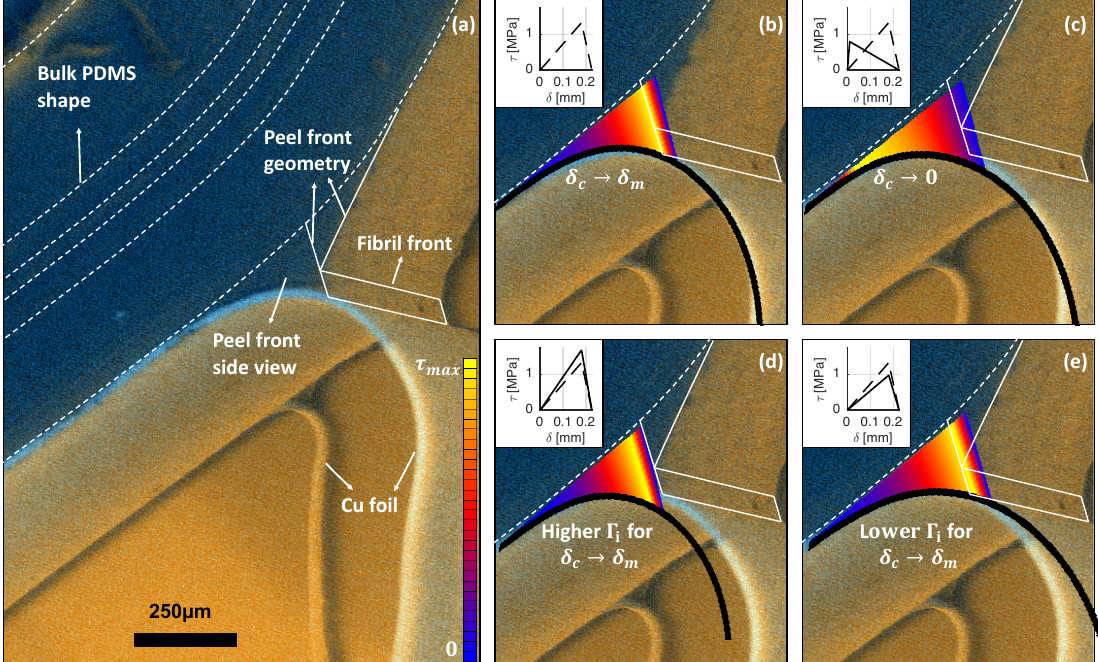
Figure 7. Side view of the ESEM images of the alternative 180 ◦ peel test to which the simulations are matched. ( a ) the shape of the bulk PDMS is marked with white dashed lines, recognised under high contrast in the PDMS. The peel front geometry is drawn with solid white lines, indicating the peel front side view and the fibril front; ( b ) the best-matching simulation (corrected for the angle of observation) superposed on the experimental image, with the applied bilinear TSL in the inset. The copper foil from the simulation is depicted in black, and the acting tractions in the CZ are colour coded. An adequate agreement with the simulation is observed for the copper curvature and the FPZ shape; ( c – e ) overlays of simulations that do not accurately represent the copper curvature, with each used TSL depicted as a solid line in the inset, while the best-matching TSL corresponds to the dashed line. These simulations clearly show the sensitivity of the CZ parameters and shape with respect to the copper curvature and the peel front